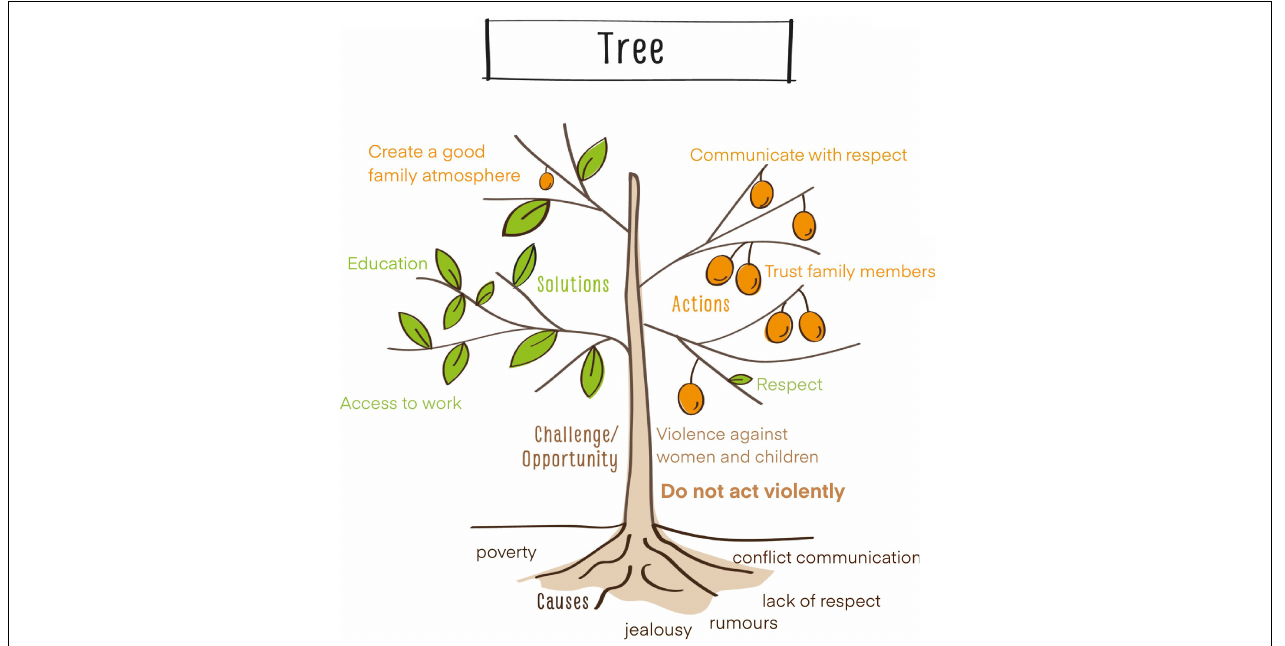
FIGURE 2 | The results of one group discussion applied in the generic canvas of an action tree – synthesis drawing made by the facilitator to capitalize on Academy experiences. All canvasses can be adapted to different topics.